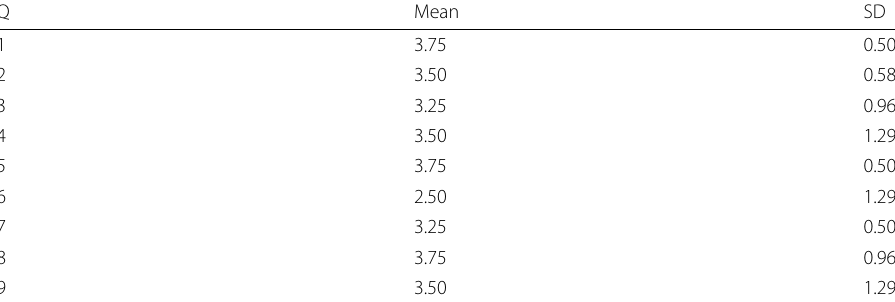
Table 5 Teachers’ answers to the